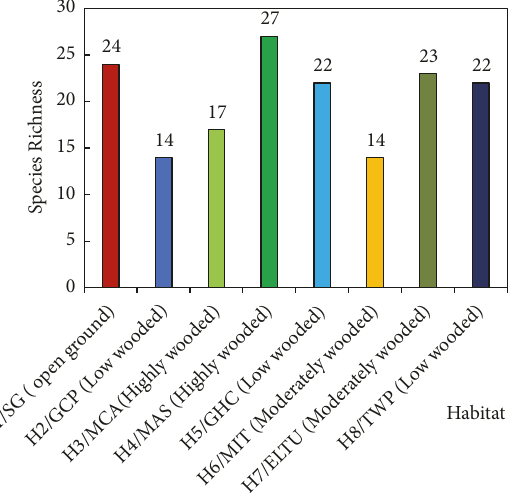
Figure 3: Variation of total abundance of species between different habitats. Figure 4: Variation of species richness among habitats.